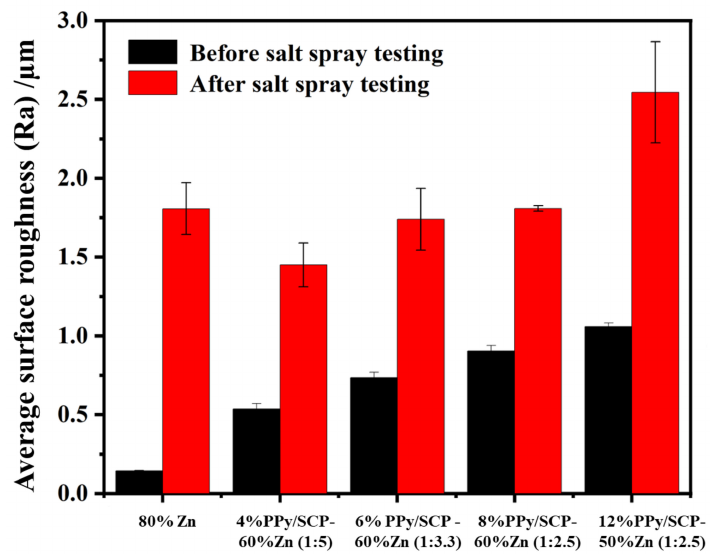
to zinc dusts (1:2.5), the lower content of zinc powder (50%) leads to a higher roughness variation and a worse surface defect.